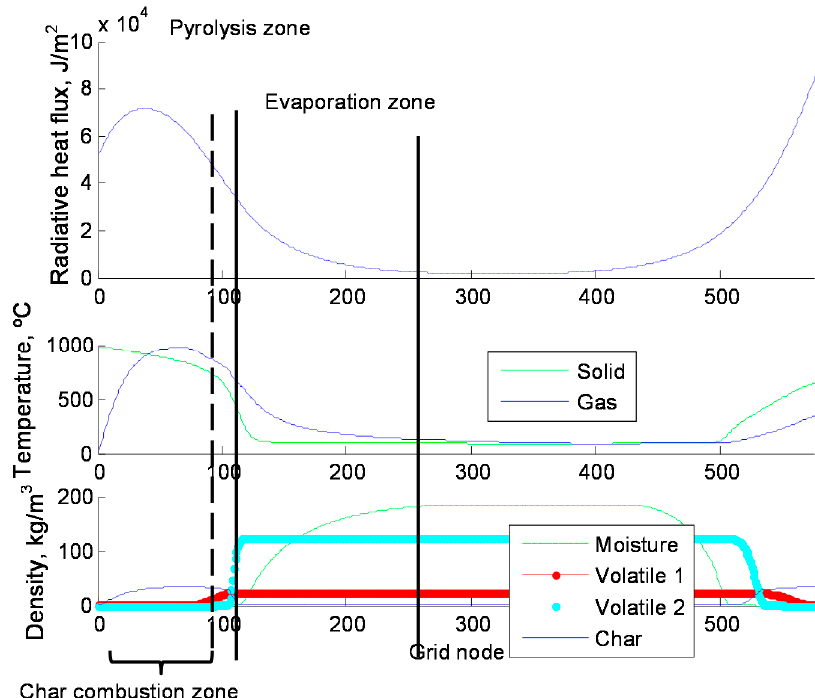
Figure 4. Simulation results from the enhanced model.